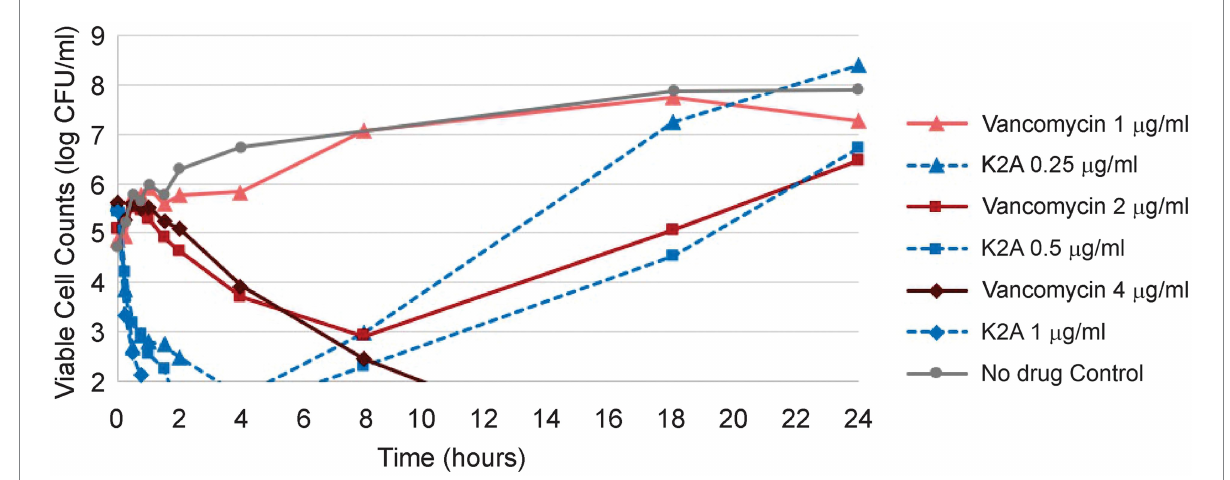
FIGURE 2 Kill kinetics of Mu1140 analog K2A compared to vancomycin. Half (0.5×) the MIC (1 μ g/ml and 0.25 μ g/ml for vancomycin and K2A, respectively), 1 × MIC (2 μ g/ml and 0.5 μ g/ml for vancomycin and K2A), and 2 × MIC (4 μ g/ml and 1.0 μ g/ml for vancomycin and K2A) were used to compare the differences in activity between K2A analog and vancomycin.